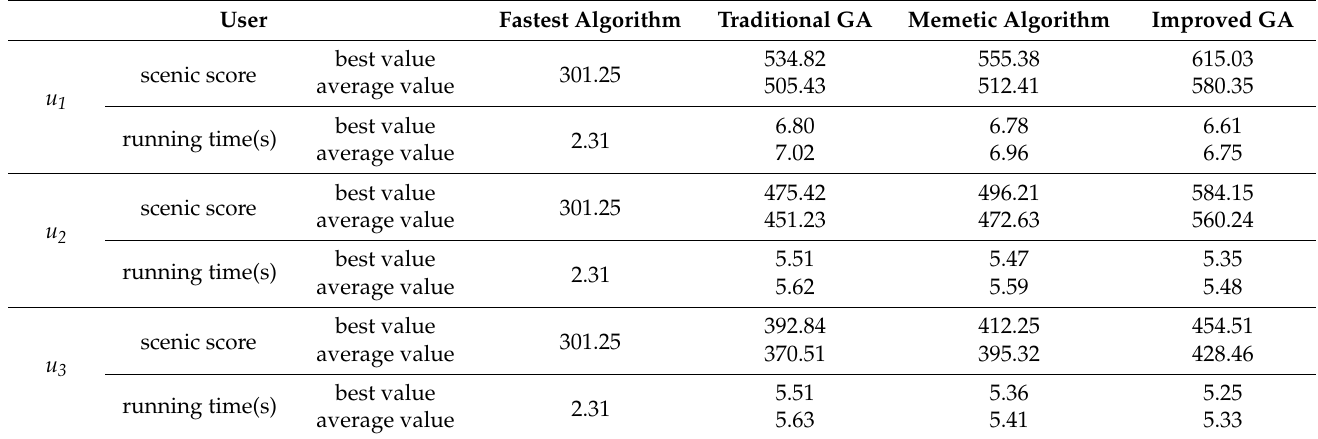
Table 3. Comparison of 30 running results of different users on four algorithms.